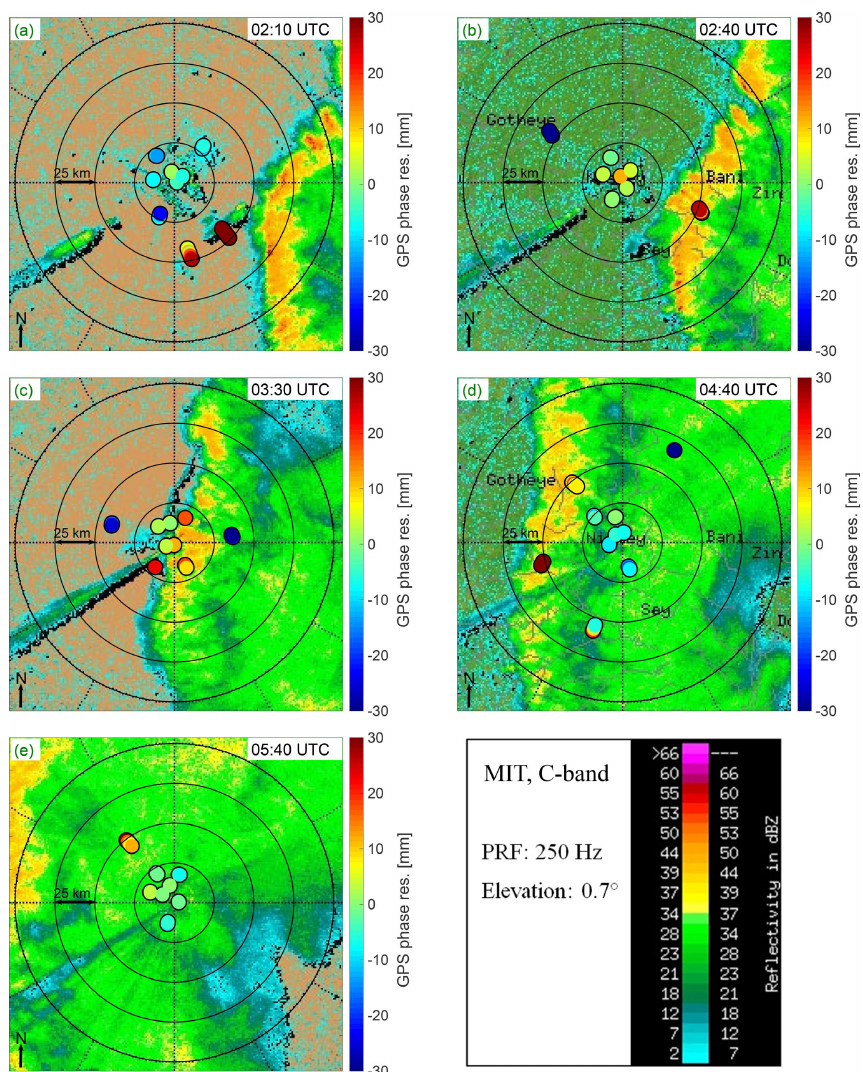
Figure 10. Similar to Fig. 6 but with GPS post-fit phase residuals from the GAMIT processing, with a 30s sampling interval, over a 5min span centered on the times of the radar